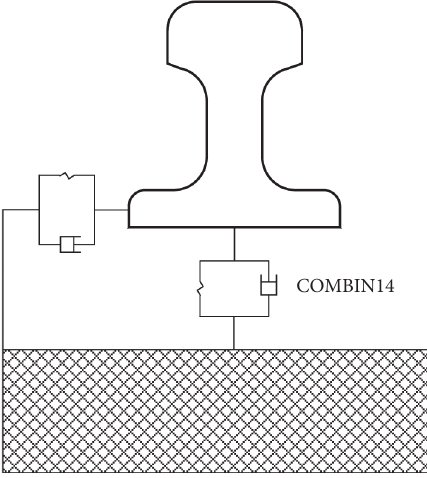
Figure 6: Spring-damper unit between the rail and the track slab.